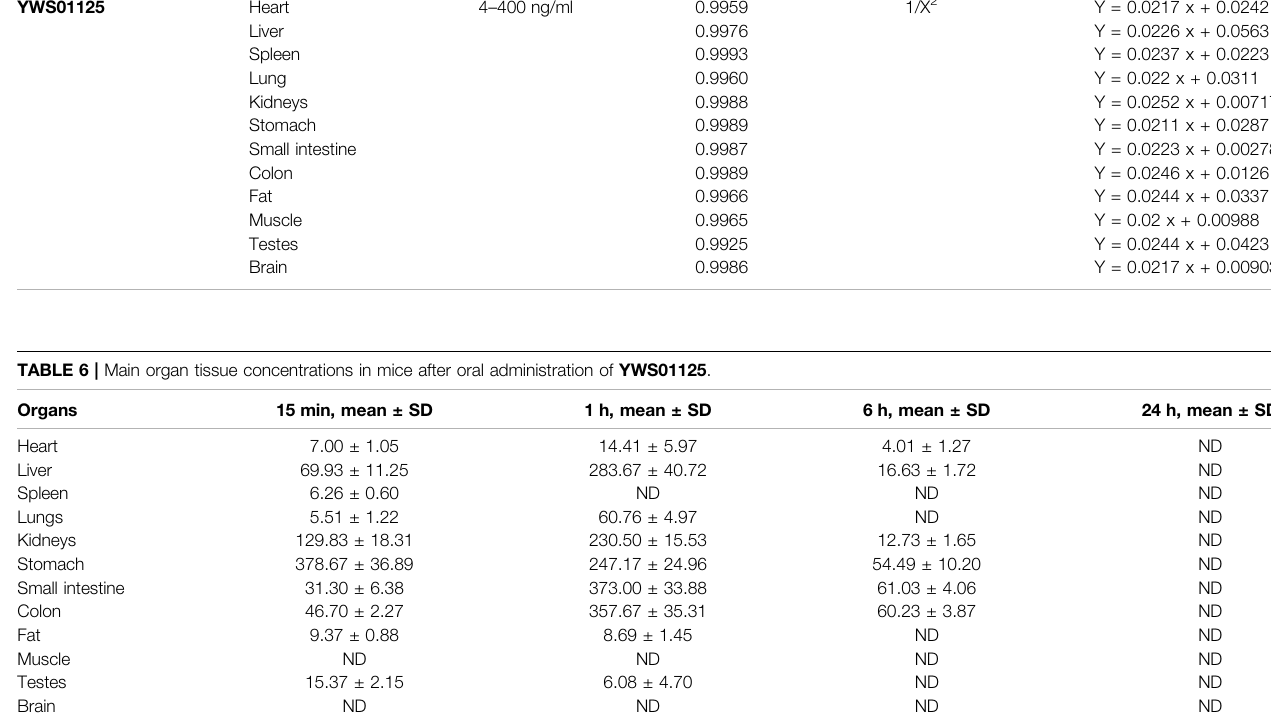
TABLE 5 | Linear ranges, correlation coef fi cients, weight factors, and regression equations for all analytes in the mouse plasma and tissue homogenates. Analysts Matrix Weight factor Regression equations YWS01125